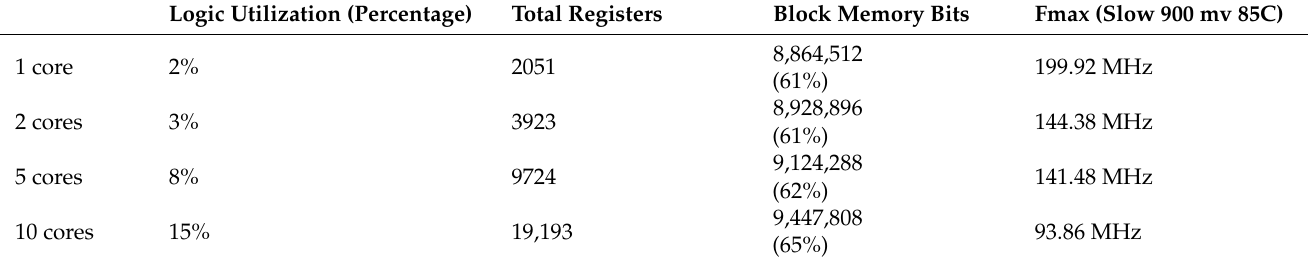
Table 7. The usage of logic resources of each system on DE-4